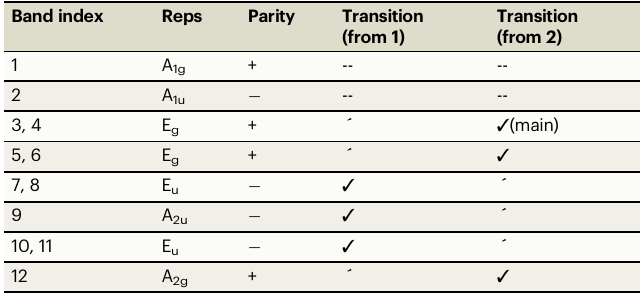
Table 1 | The electronic states at Γ , and their corresponding irreducible representations of D 3d , parity of space inversion